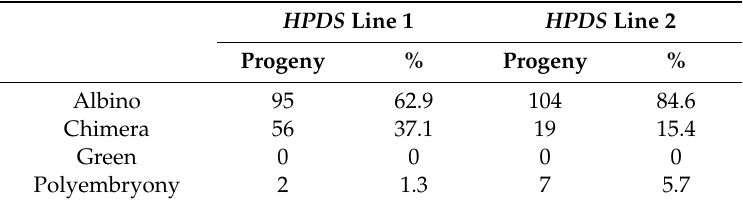
Figure 4. The combined types and frequencies of CRISPR / Cas9-induced mutations in the Hieracium PDS gene, mediated by the three di ff erent sgRNAs, determined by NGS in 18 T0 independent transformants. ( A ) Frequency of insertions [I], deletions [D], substitutions [S], and combined [C] mutation types; ( B ) Frequency of di ff erent mutation lengths regardless of the mutation types; ( C ) Percentage of bases inserted for the 1-bp insertions A = adenine, T = thymine, G = guanine, C = cytosine; ( D ) Frequency of each mutation type for all of the mutations induced by the three sgRNAs. I = insertion; D = deletion; S = substitution; C = combined mutation. Frequencies are shown above the bars in A – C . Table 2. Phenotypes of T1 seedlings from two independent primary (T0) transformants. Seeds derived from chimeric